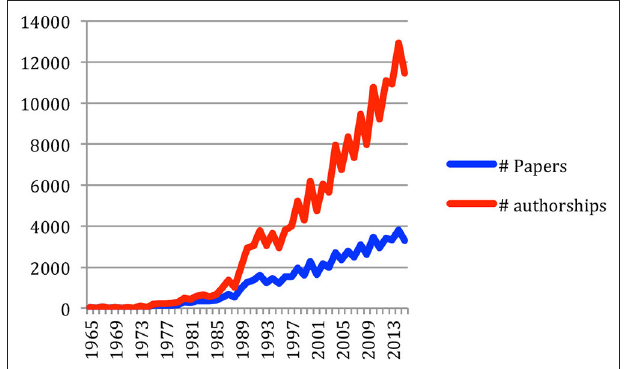
FIGURE 14 | Number of papers and authorships over time.